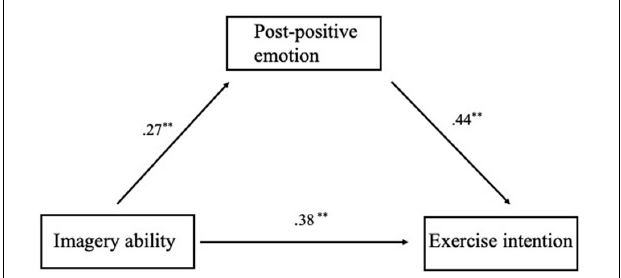
FIGURE 1 | A mediation model of positive emotion between imagery ability and exercise intention. Pre-positive emotion is controlled for in the regression of post-positive emotion (coefficients = − 0.35, p < 0.01) and exercise intension (coefficients = − 0.72, p <